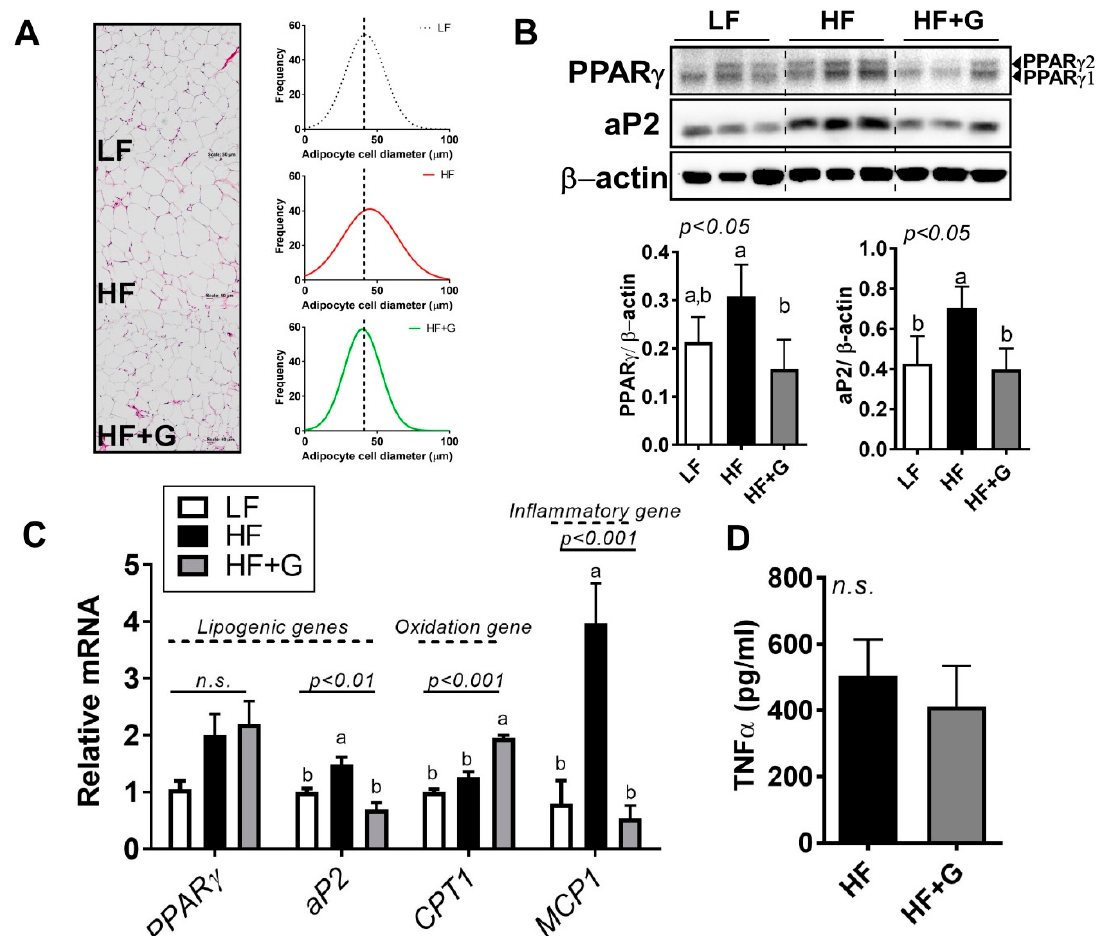
Figure 4. Ginger supplementation attenuated HF-induced adipocyte hypertrophy. Male 6-week-old C57BL/6 mice were fed an LF (white), HF (black), or HF + G (gray) diet for 7 weeks ( n = 4–5 per group). ( A ) H&E staining of adipose tissue (20 × magnification) and adipocyte size distribution (Gaussian curve fitting). ( B ) protein expression of peroxisome proliferator-activated receptor γ (PPAR γ ) and adipocyte protein 2 (aP2) in epididymal adipose tissue, quantified by Western blot. β -Actin was used as a loading control. ( C ) mRNA expression of PPAR γ , aP2 , CPT1 , and MCP1 in epididymal adipose tissue determined using real-time PCR. ( D ) TNF α cytokine production by ELISA. Data are expressed as the mean ± SEM ( n = 4–5). n.s. represents no significance. Bars with different letters are significantly different according to one-way ANOVA with Bonferroni’s comparison test.